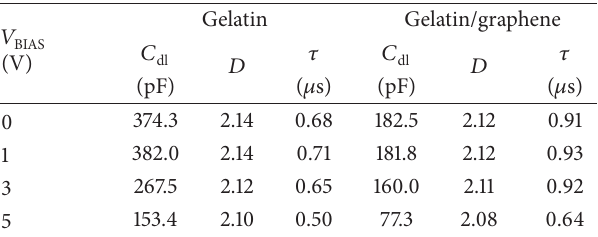
Table 3: Extracted parameters from Nyquist spectra fitting using (3) and (4) for gelatin and gelatin/graphene